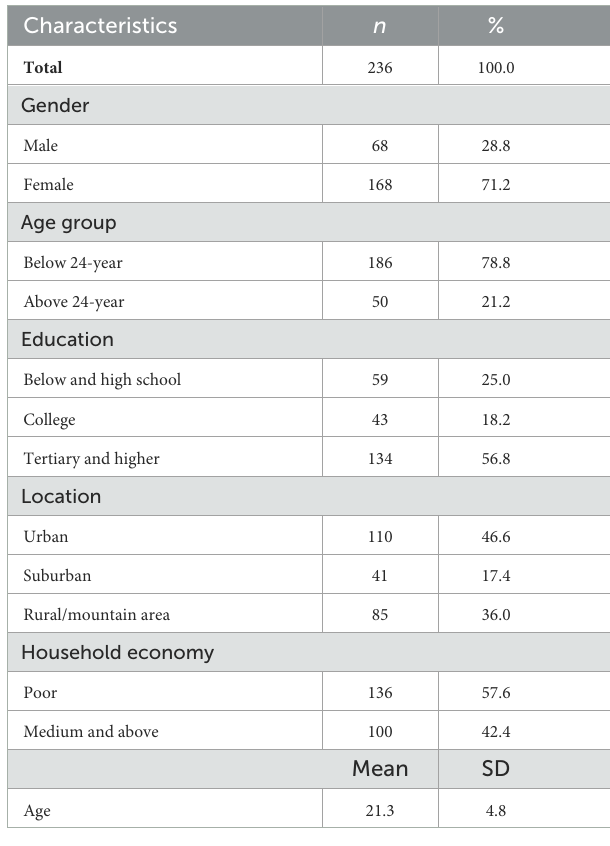
TABLE 2 Demographic characteristics of